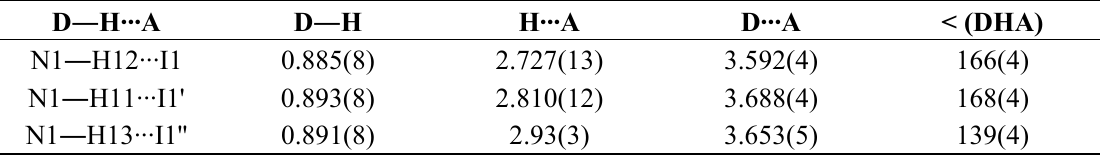
Table 2. Hydrogen bond parameters for 18dbt [Å and